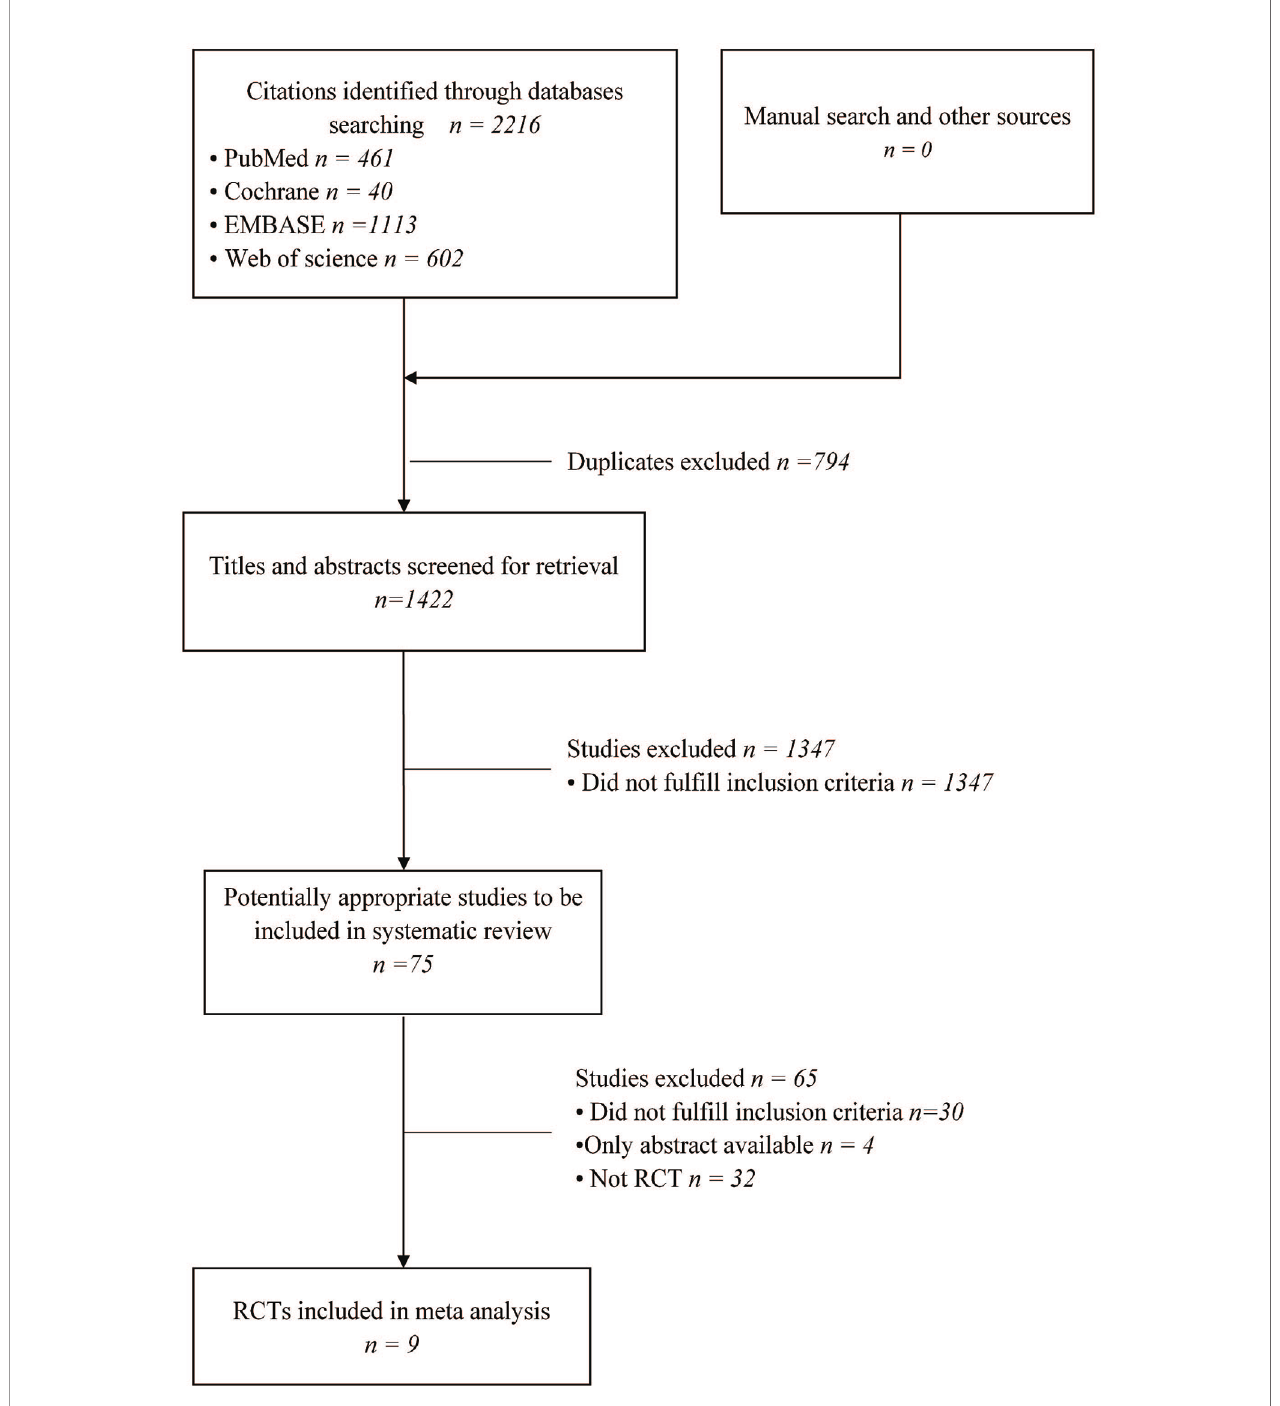
FIGURE 1 | PRISMA fl ow diagram of study selection for the systematic review and